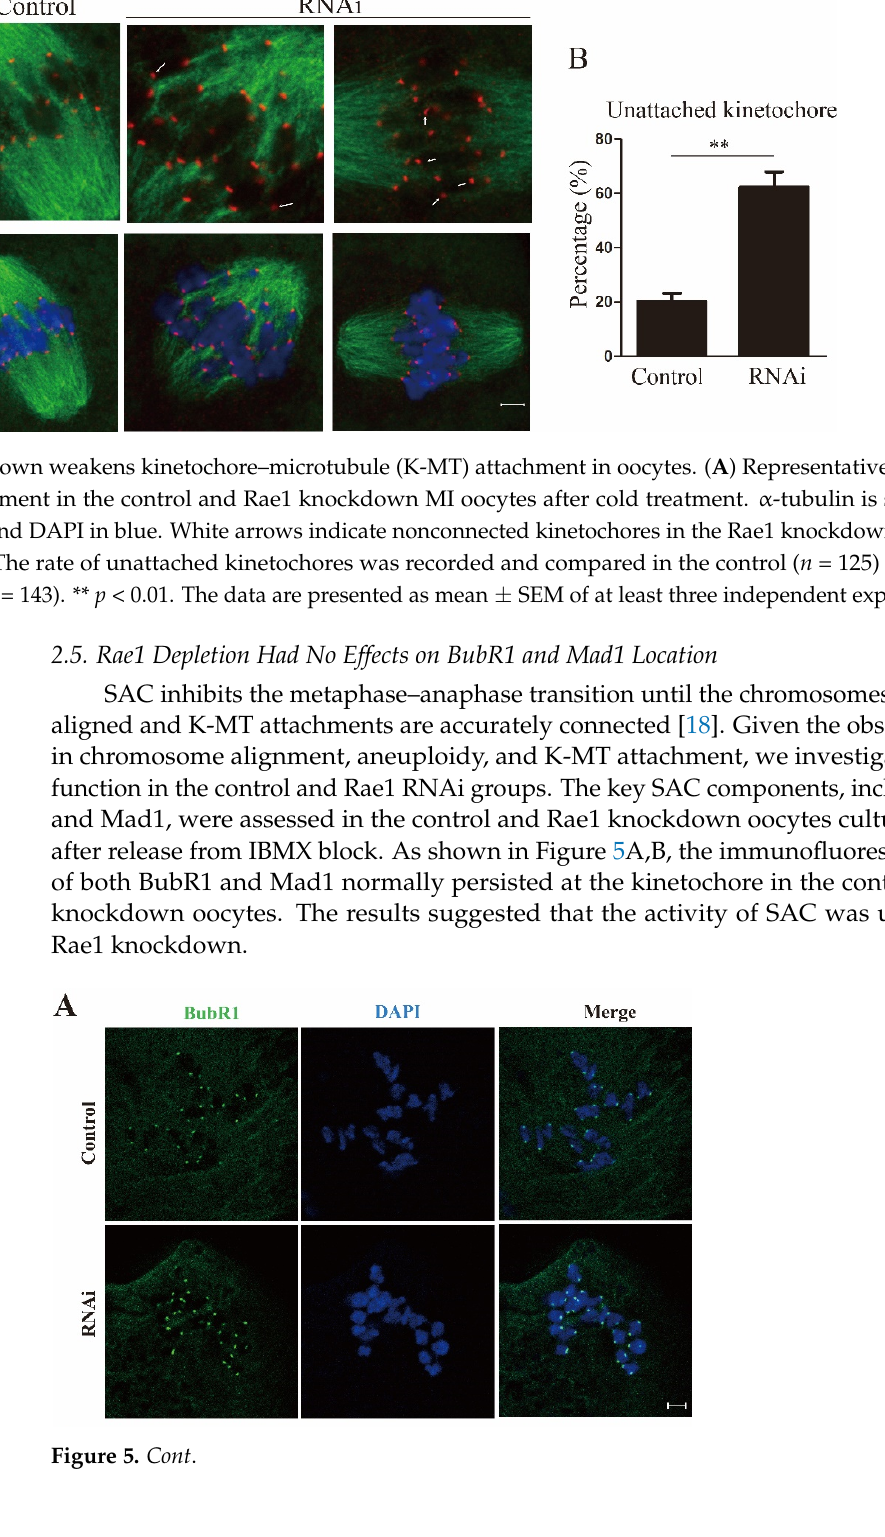
Figure 5. The location of BubR1 and Mad1 was not affected in the Rae1 knockdown oocytes. After Rae1 knockdown, GV stage oocytes were cultured for 8.5 h and then collected for immunofluores- cent staining of BubR1 and Mad1. ( A ) Confocal image of BubR1 localization in the control and Rae1 knockdown oocytes by chromosome spreading. BubR1 is shown in green and DAPI in blue. Scale Bar = 5 μm. ( B ) Confocal image of Mad1 localization in the control and Rae1 knockdown oocytes by chromosome spreading. Mad1 is shown in red and DAPI in blue. Scale Bar = 5 μm. 2.6. Rae1 Depletion Decreases the Protein Level of securin but Not Cyclin B Anaphase-promoting complex or cyclosome (APC/C) directly controls the meta- phase–anaphase transition by regulating the proper degradation of securin and cyclin B [21]. In this experiment, we assessed the protein levels of securin and cyclin B in the con- trol and Rae1 knockdown oocytes at the MI stage. As shown in Figure 6, the protein level of securin was significantly decreased in the Rae1 knockdown oocytes; however, the pro- tein levels of both cyclin B1 and cyclin B2 were similar between the control oocytes and the Rae1 knockdown oocytes, which indicated that Rae1 specifically modulates the pro- tein level of securin.